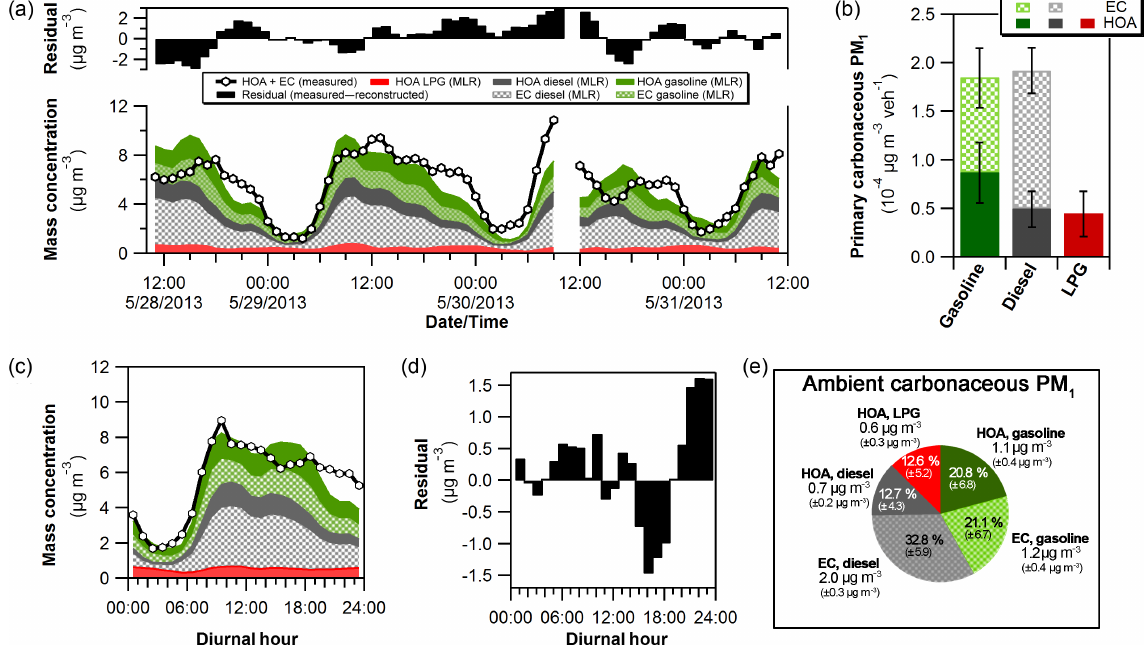
Figure 3. (a) Time series of engine-type separated HOA and EC in PM 1 , sum of actual measured HOA and EC in PM 1 , as well as residuals as the difference between resolved HOA + EC and measured HOA + EC. (b) Contribution of engine-type separated HOA and EC to PM 1 normalized by the total number of vehicles per engine category; vehicle composition based on traffic count (28–31 May 2013) and vehicle number scaled to average annual daily traffic (Transport Department, 2014), with uncertainties from resolved fit parameters (MLR) included. (c) Diurnal variation of vehicle-type separated HOA and EC concentrations as well as sum of actual measured HOA and EC in PM 1 . (d) Diurnal variation of residuals as the difference between resolved HOA + EC and measured HOA + EC in PM 1 . (e) Average contribution of engine-type separated HOA and EC in total reconstructed HOA + EC in PM 1 , with uncertainties from resolved fit parameters (MLR)